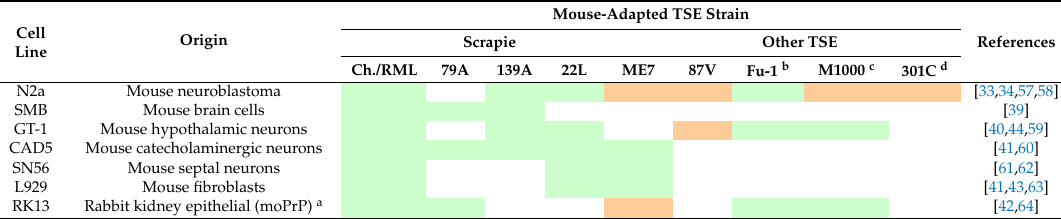
Table 1. Cell lines commonly used in prion